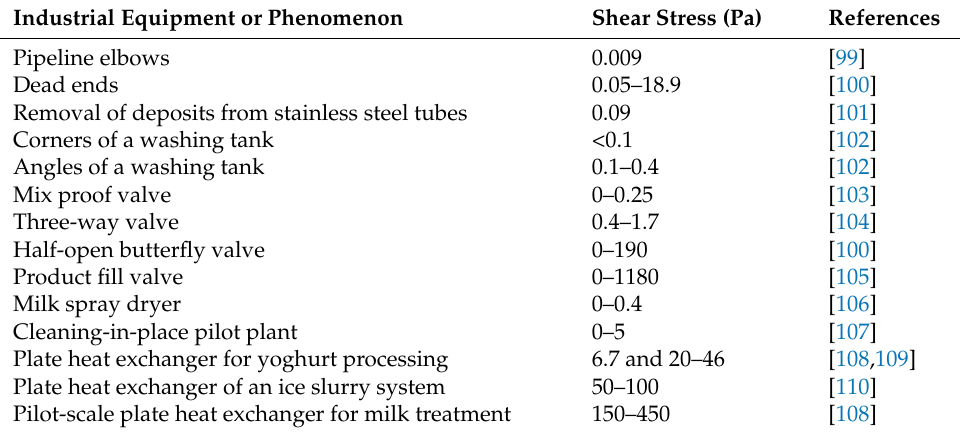
Table 4. Examples of industrial processes and their associated shear stress